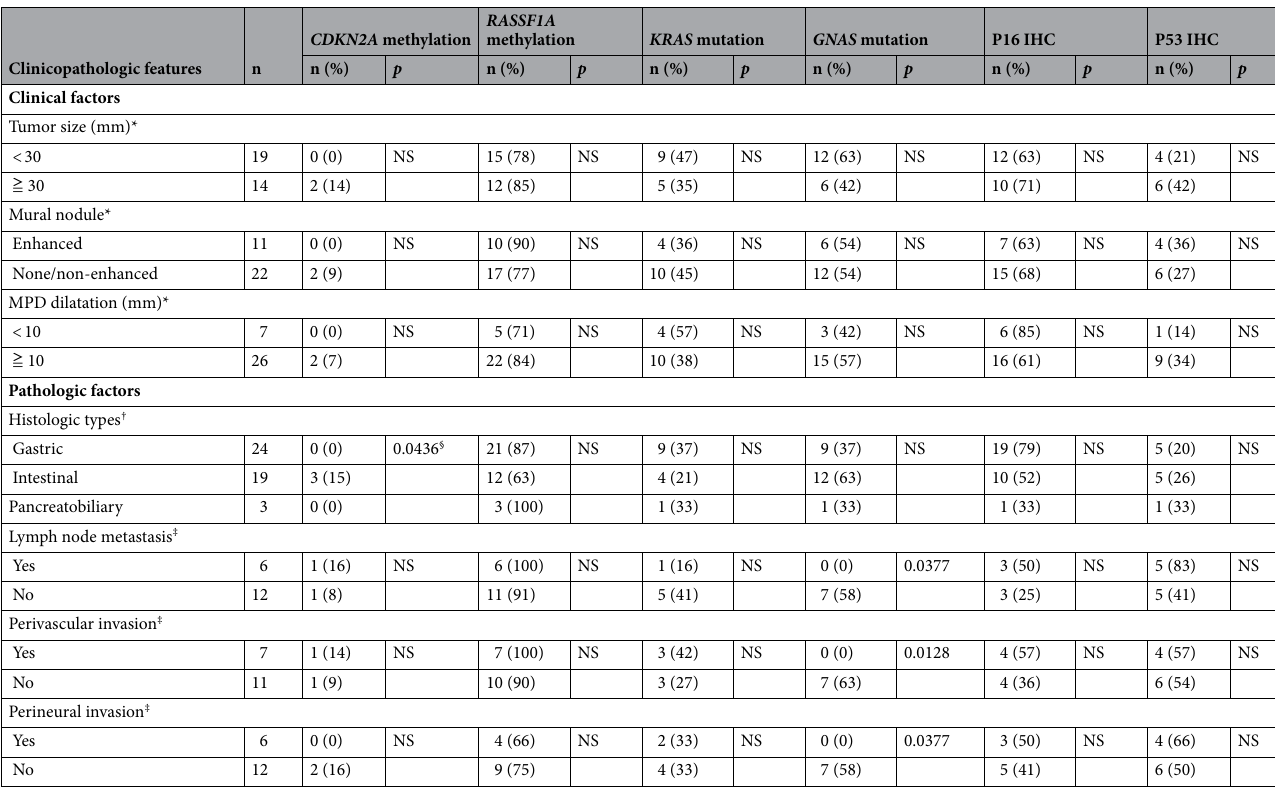
Table 2. Relationships between the clinicopathologic parameters and methylation, mutation, and IHC results. No significant differences were observed for LINE-1 methylation, BRAF mutation, or the IHC results for RASSF1. *All cases. † All dissected tissue regions. ‡ Only malignant-potential cases. § p -value for comparison between gastric and intestinal